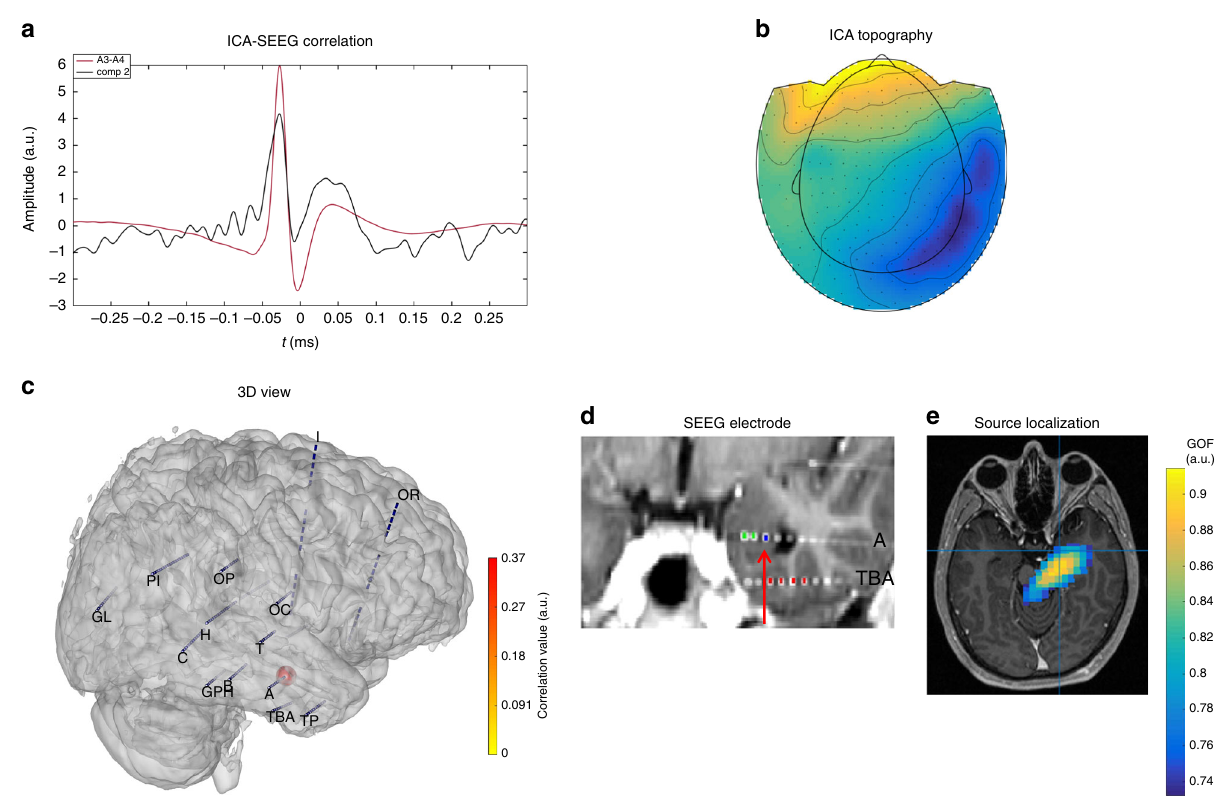
Fig. 1 Example of purely mesial network, correlated with amygdala in P5. a SEEG/ICA correlation: in black the ICA time course and in red the time course on the SEEG contact where signi fi cant correlation was observed. b MEG topography of the ICA component. c 3D representation of MEG-SEEG correlation. Color (from yellow to red, refer to color bar) and sphere dimension correspond to the correlation value. d MRI (3D T1) with reconstruction of SEEG electrodes (showing electrodes A and TBA on the right hemisphere): the arrow indicates the contact (the most mesial within the bipolar derivation) with the highest correlation value. This contact, within electrode A, is located in the right amygdala. e Source localization (single dipole) of the ICA component overlaid on patient MRI, showing a con fi dence interval that includes regions sampled by the mesial contacts of electrode